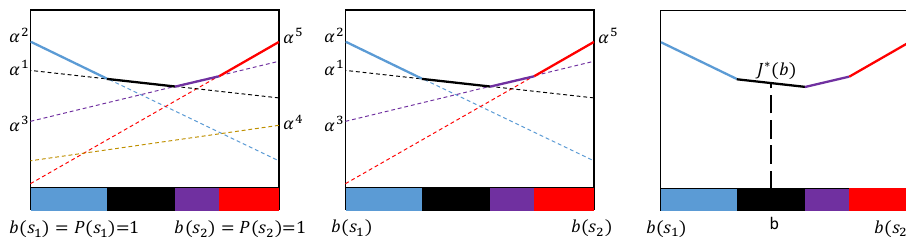
Figure 4. Alpha vectors over belief space in a two-state partially observable Markov decision process (POMDP); bold segment of the alpha vectors constitute a piecewise linear and convex (PWLC) value function. α 4 is a redundant vector and can be